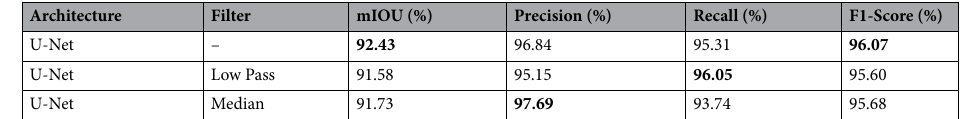
Table 4. Comparison of the proposed method with and without the application of noise removal filter on the CDTLs. Best results are shown in [bold].